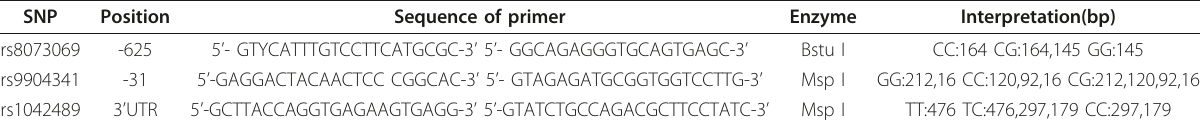
Table 1 PCR-RFLP-based assay of survivin SNPs SNP